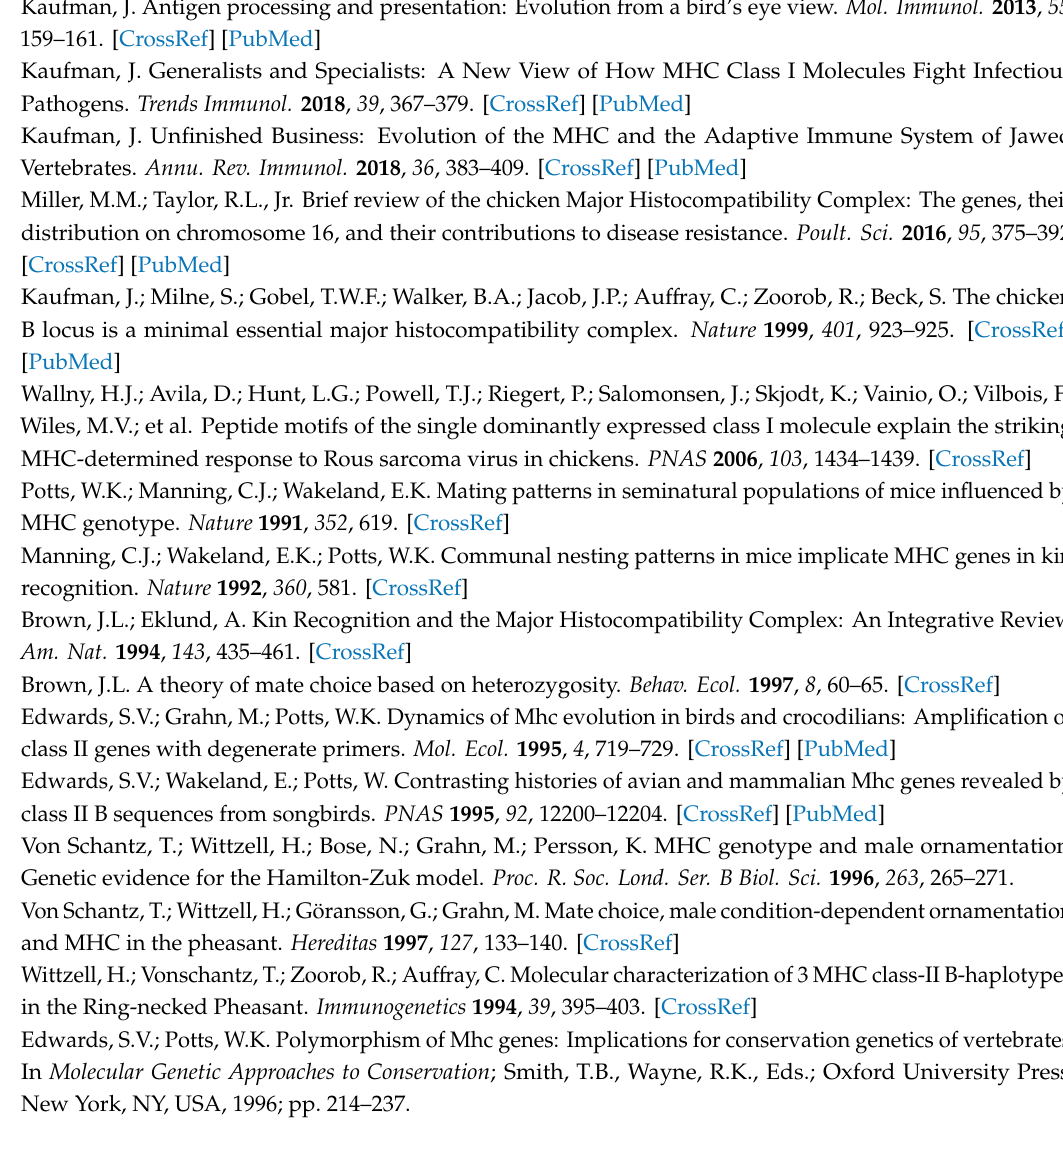
Table S1: Data for Figures 2 and 3, modified with permission from Minias et al. 2018. Genome Biology and Evolution 2018, 11 (1), 17–28 (ref.